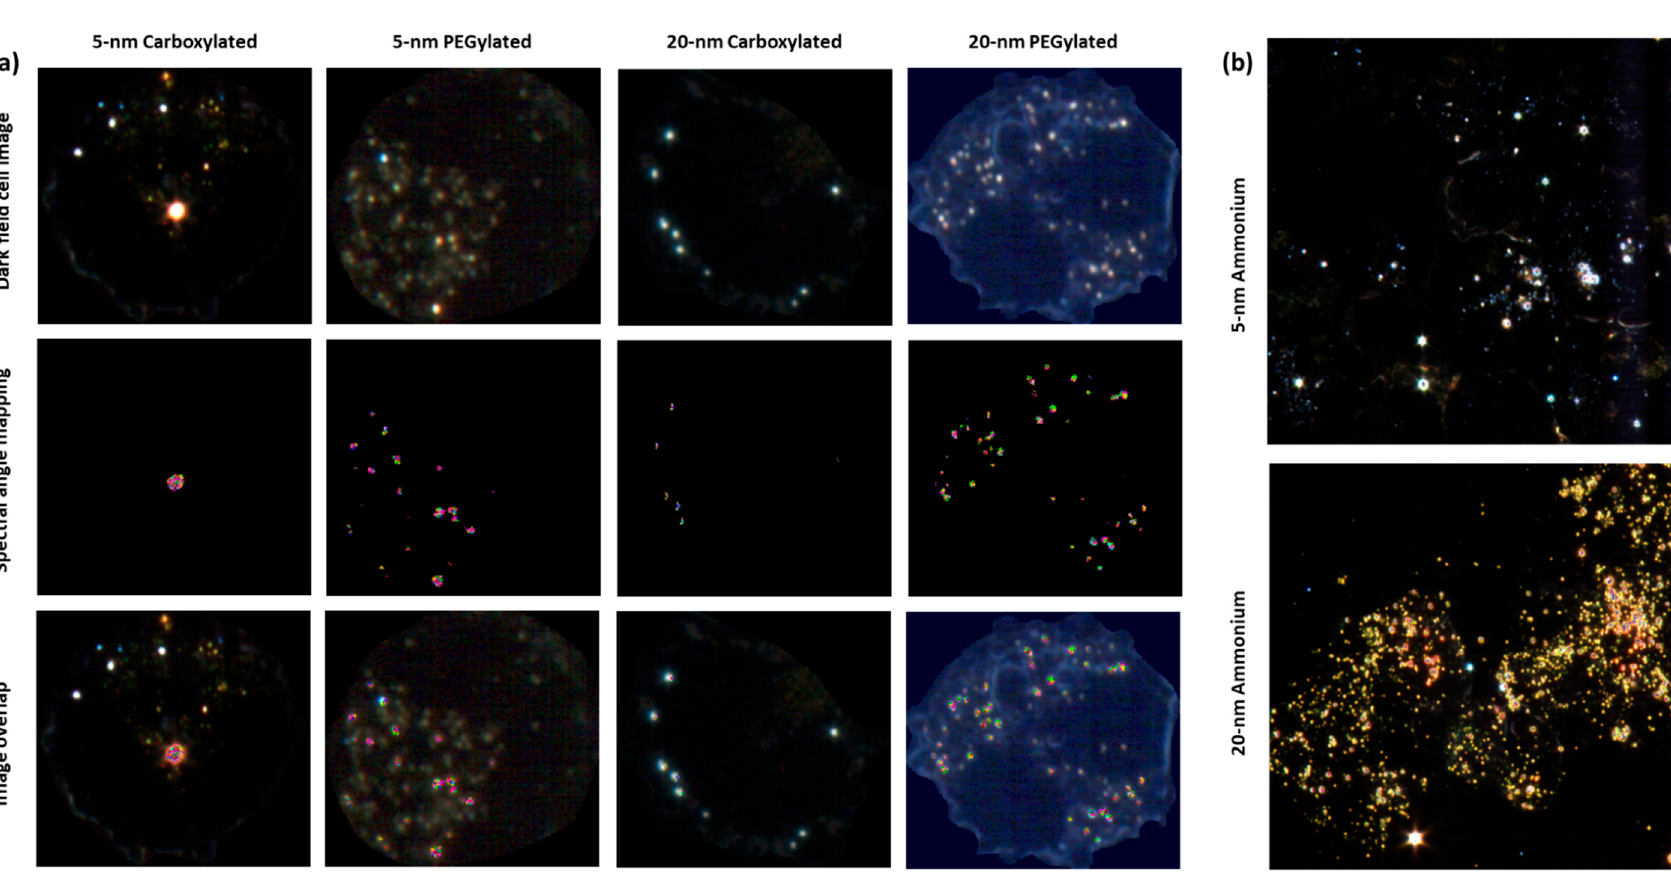
Figure 4. Hyperspectral image analysis of BEAS-2B cells after a 48-h treatment with 5 µg/mL gold nanoparticles (NPs). ( a ) Representative images of cells exposed to ~5-nm-core carboxylated, ~5-nm-core poly(ethylene glycol) (PEG)ylated, ~20-nm-core carboxylated, or ~20-nm-core PEGylated gold NPs. ( b ) Dark-field view of several cells exposed to ~5-nm- or ~20-nm-core ammonium-functionalized gold NPs.